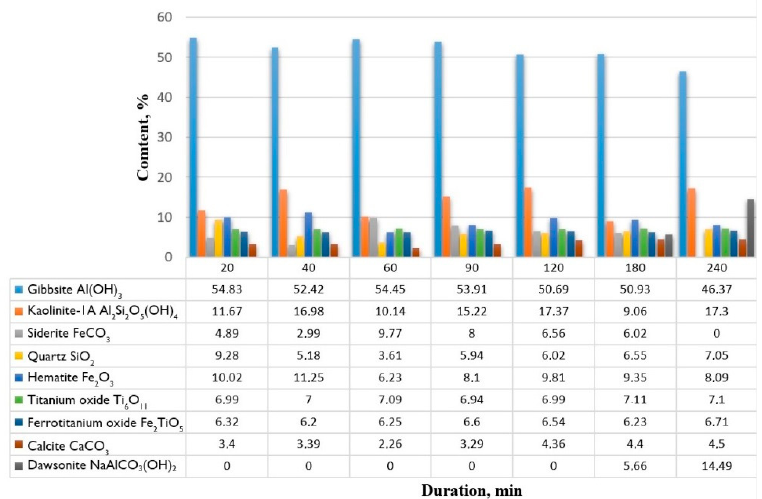
Figure 6. The phase composition of bauxite samples depending on the duration of chemical activation at the temperature of 120 ◦